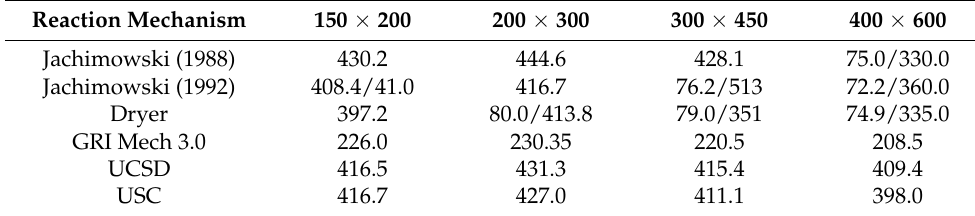
Table 2. Flow field oscillation calculated for various reaction mechanisms.